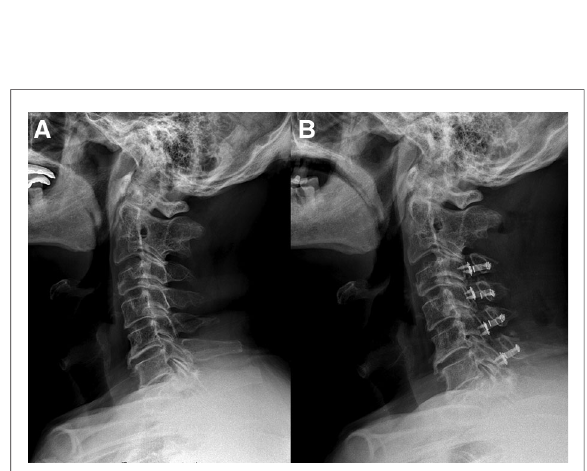
FIGURE 4 A 63-year-old male patient treated with C4 – C7 laminoplasty. ( A ) Preoperative lateral cervical radiograph (CSVA=29.5 mm, T1S= 21.8°). ( B ) Lateral cervical radiograph at fi nal follow-up (18 months after surgery, CSVA=30.9